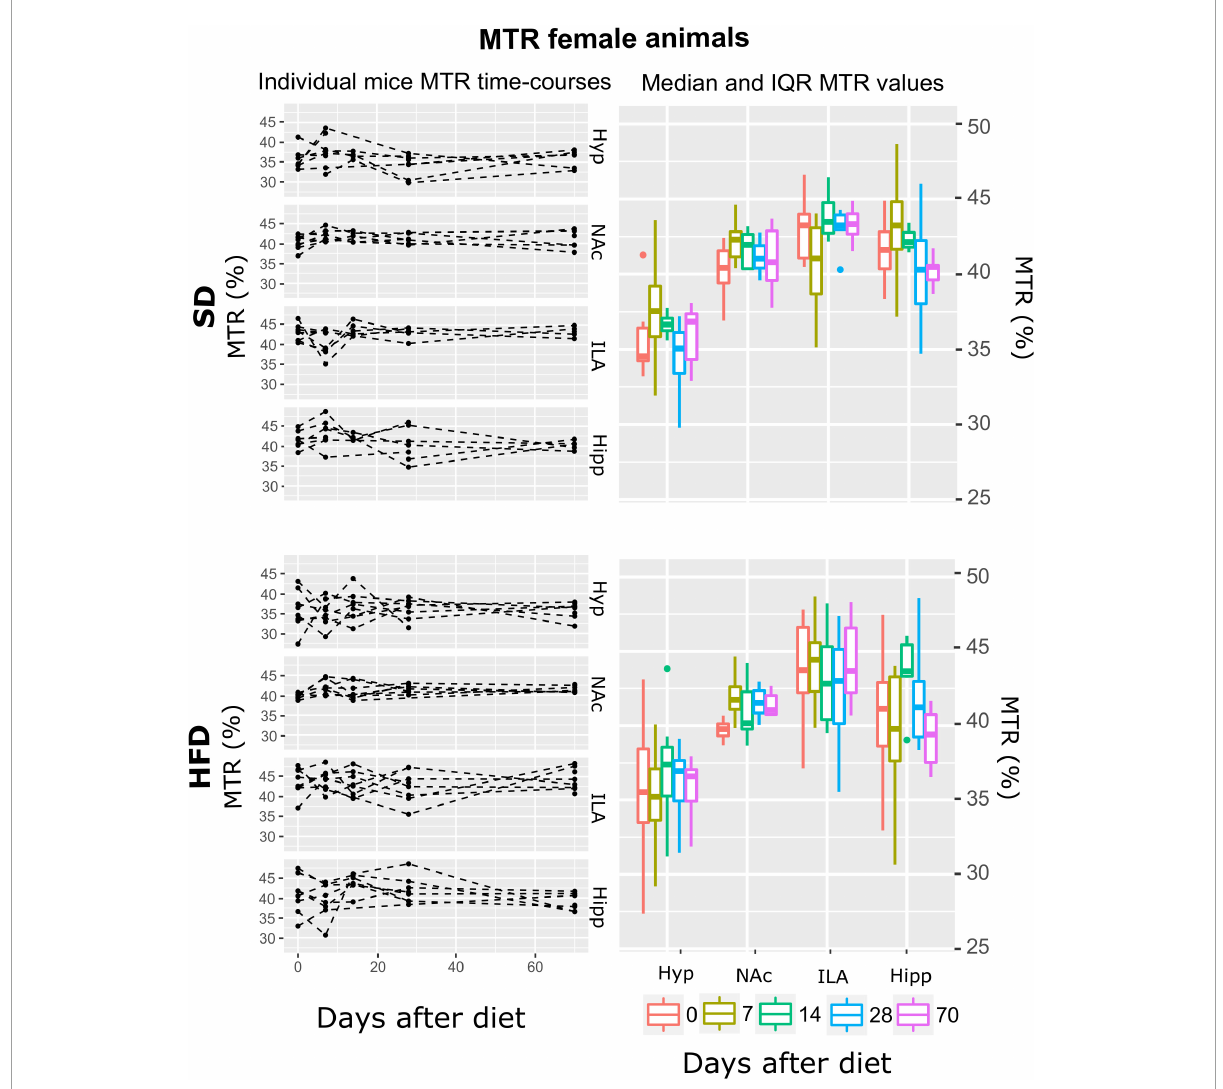
FIGURE6 MTR changes on female mice during HFD or SD consumption. MTR values on SD-fed (top boards) or HFD (bottom boards) female animals in the four cerebral regions investigated: hypothalamus (Hyp), nucleus accumbens (NAc), ipsilateral area (ILA) and hippocampus (Hipp) at all time points measured. Left panels depict the individual MTR regional values at each time point, with dashed lines connecting the adjoining points. Right panels show box plots of MTR vs. time-points for the 4 regions evaluated, with each color representing the specific time-point, as days after diet diversification. Note how MTR does not depict remarkable changes with time or